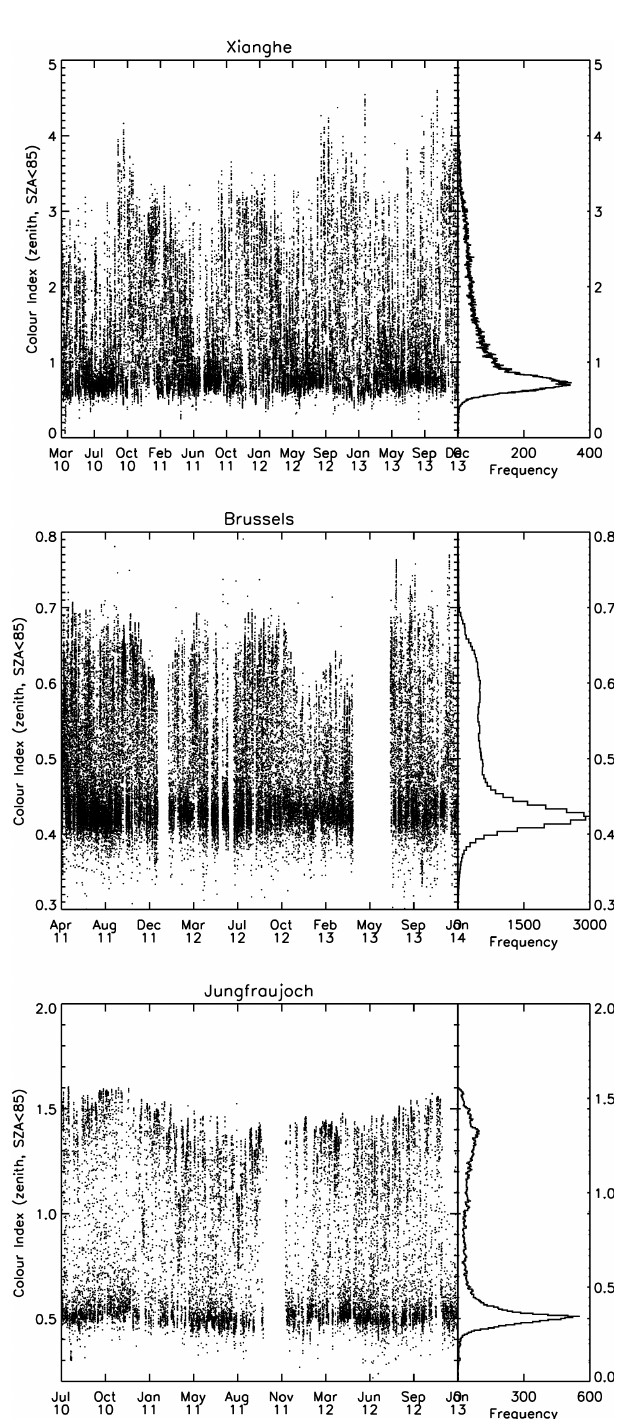
Figure 4. The calculated zenith CI values and frequency distribu- tion for the full Xianghe, Brussels, and Jungfraujoch data